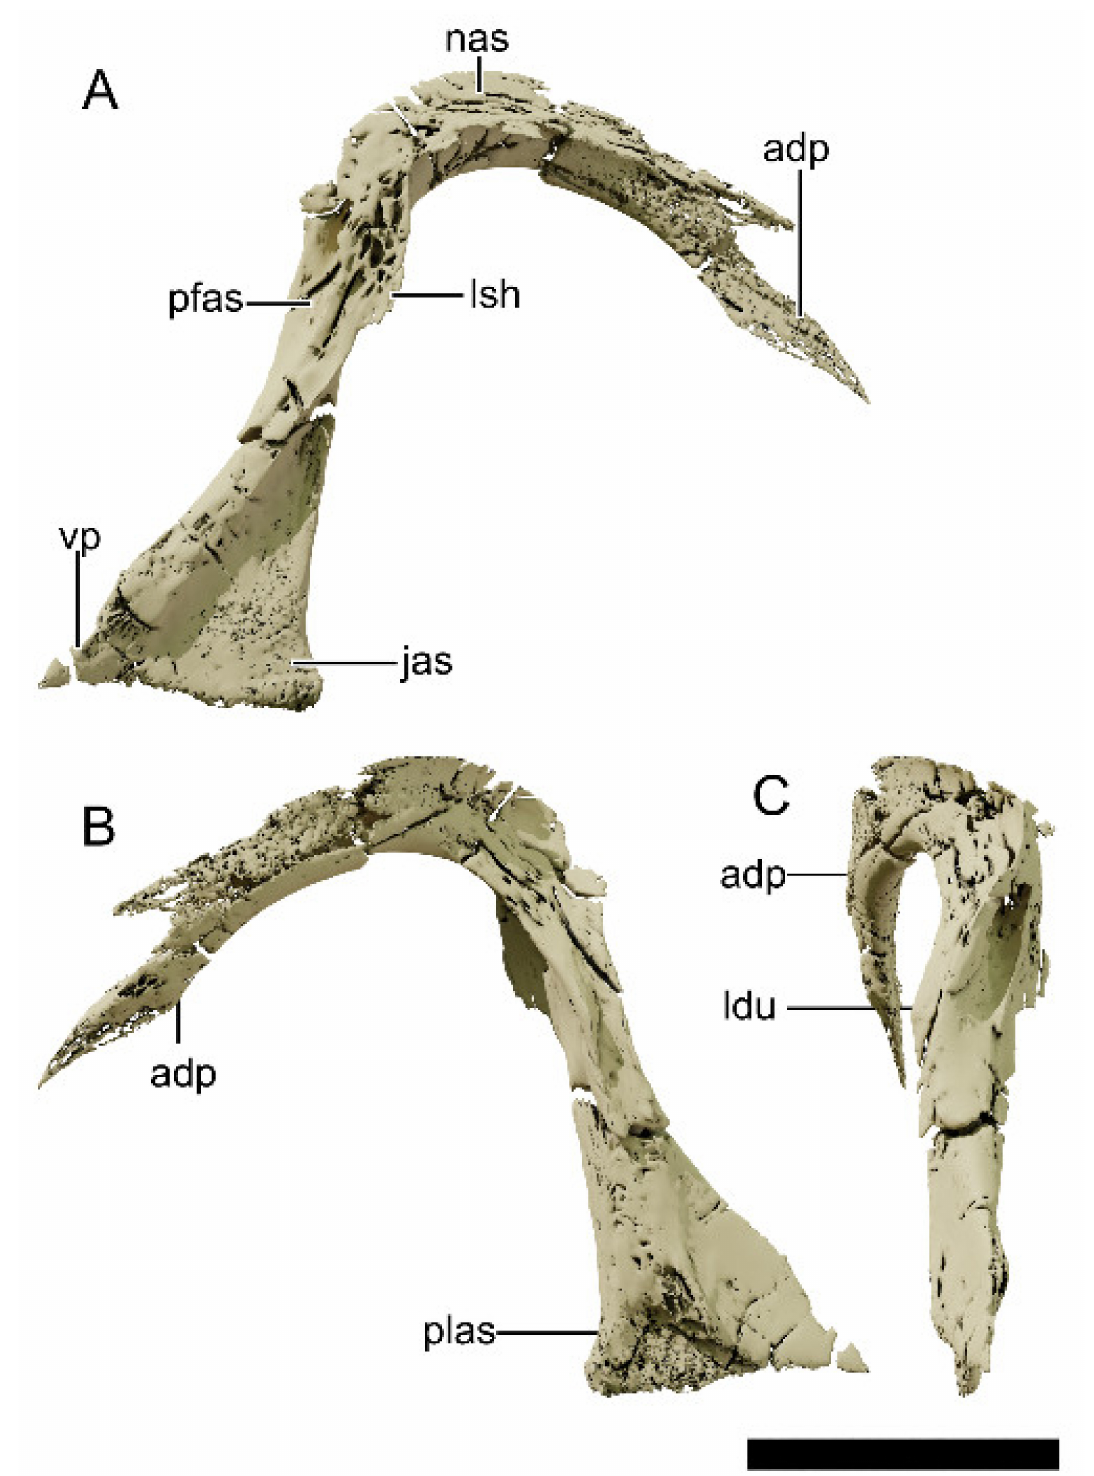
Figure 13. Digital reconstruction of the right lacrimal of NHMD 164758. ( A ) Lateral view. ( B ) Medial view. ( C ) Posterior view. Abbreviations: adp, anterodorsal process; fo, foramen; jas, articular surface for the jugal; ldu, lacrimal duct; lsh, lateral sheet of bone; nas, articular surface for the nasal; pfas, articular surface for the prefrontal; plas, articular surface for the palatine; vp, ventral process. Scale bar = 20